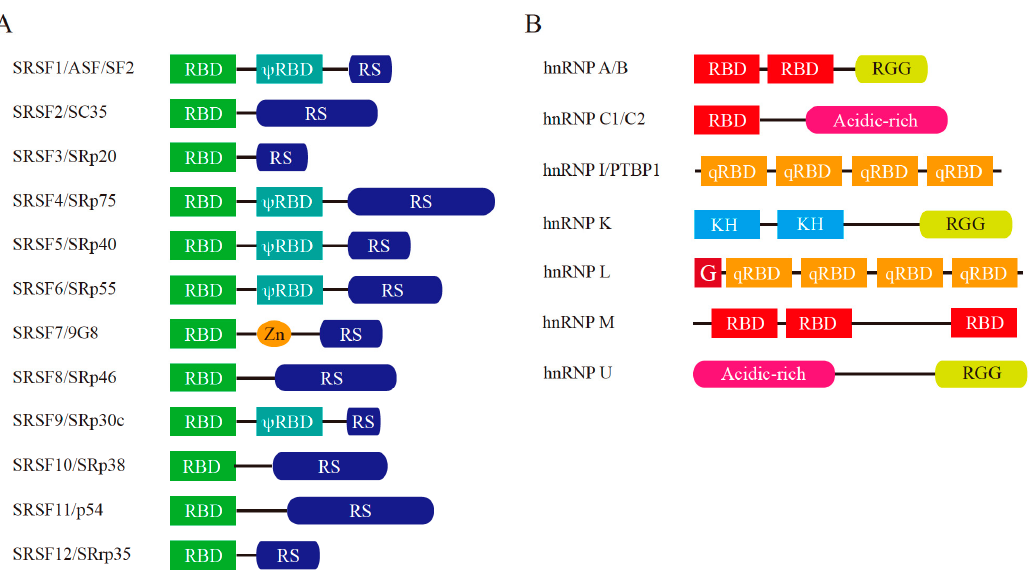
Figure 4. Schematic representation of major splicing regulators: serine-arginine-rich (SR) proteins and heterogeneous nuclear ribonucleoproteins (hnRNPs). ( A ) Structure of human SR proteins. Current serine-arginine-rich splicing factor (SRSF) names are shown on the left together with the protein aliases. RBD: RNA-binding domain (also known as RNA recognition motif (RRM)), RS: arginine-serine dipeptide repeat-rich region, Zn: Zn-binding domain, ψ RBD: RBD homology domain. ( B ) Structure of human hnRNPs. RBD: RNA-binding domain, RGG: arginine-glycine-glycine repeat-rich region, Acidic-rich: acidic amino acid residue-rich region, qRBD: non-canonical RBD, G: Glycine rich region, KH: K homology domain.